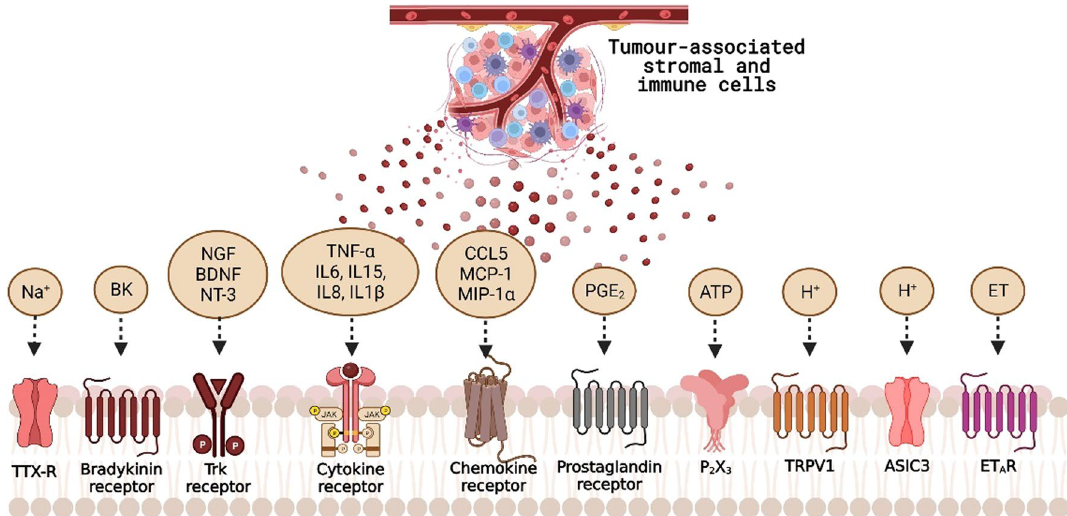
Fig. 2 Targets (receptors and ion channels) activated by pronociceptive mediators in metastatic tumour-invaded bone (Adapted from Zajac- zkowska et al. 2019 and redrawn with